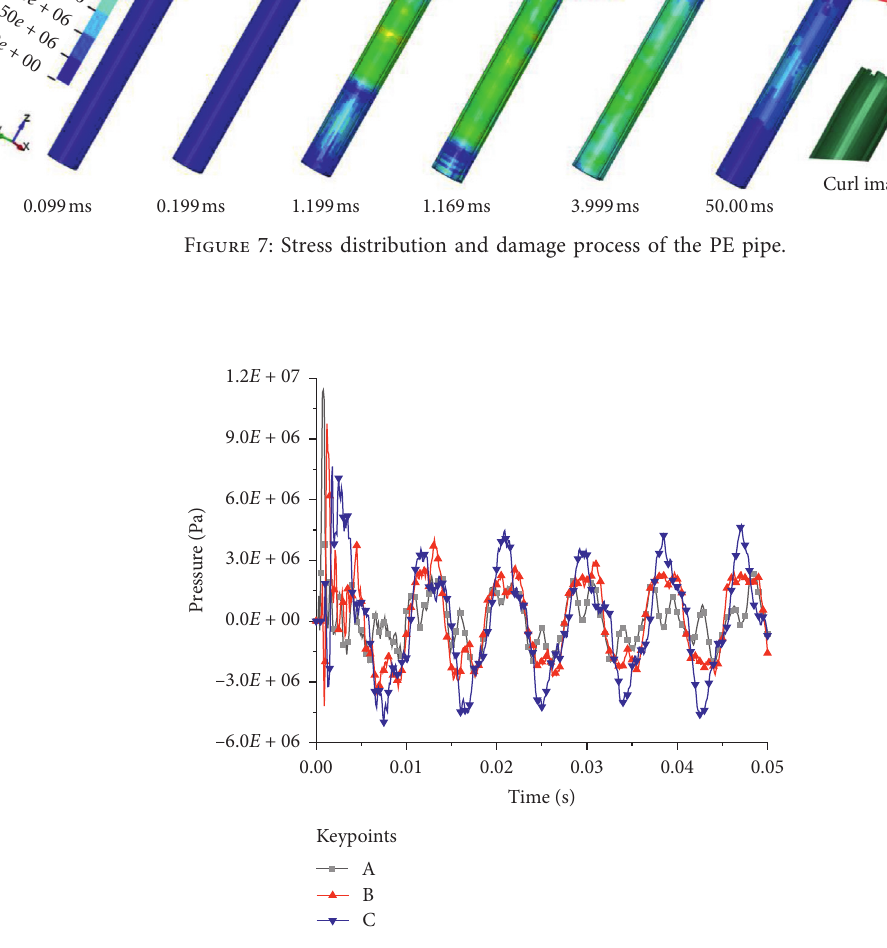
Figure 8: Pressure-time curve of keypoints in different